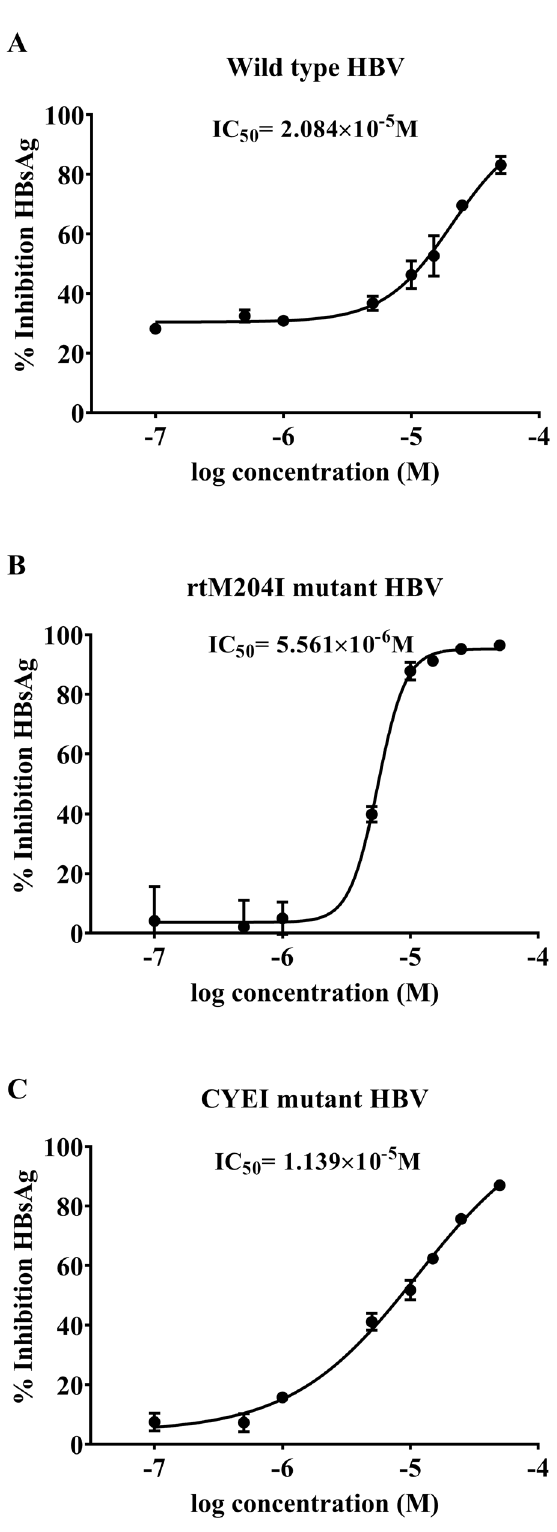
Figure 3. Dose dependent inhibition of secreted HBV surface antigen (HBsAg) by Molecule 5 encoded by ( A ) Wild type HBV and ( B ) lamivudine-resistant rtM204I mutant HBV and ( C ) tenofovir-resistant CYEI mutant